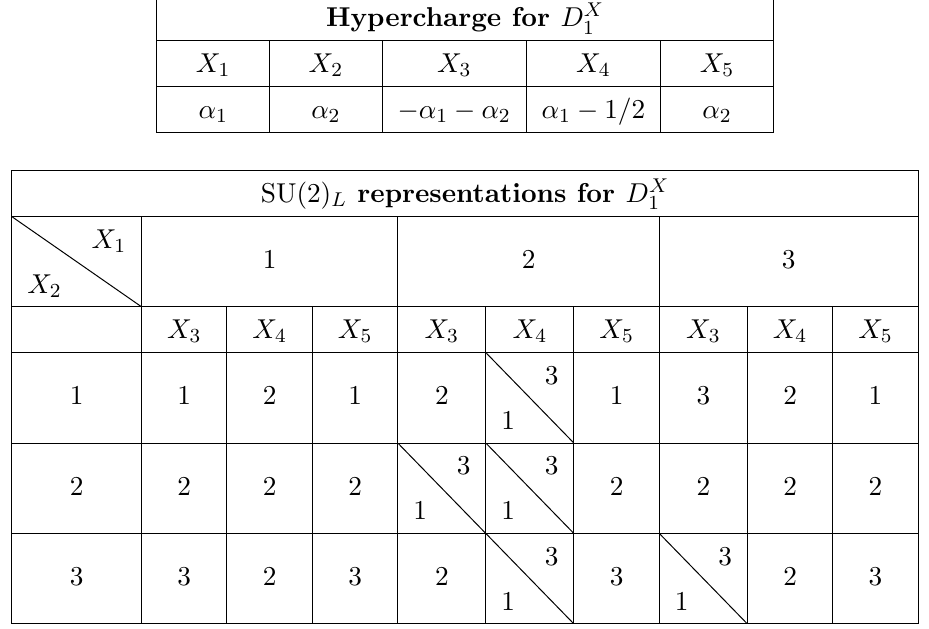
numbers of X and X in the (cid:12)rst row and column, respectively. In the cases when 1 2